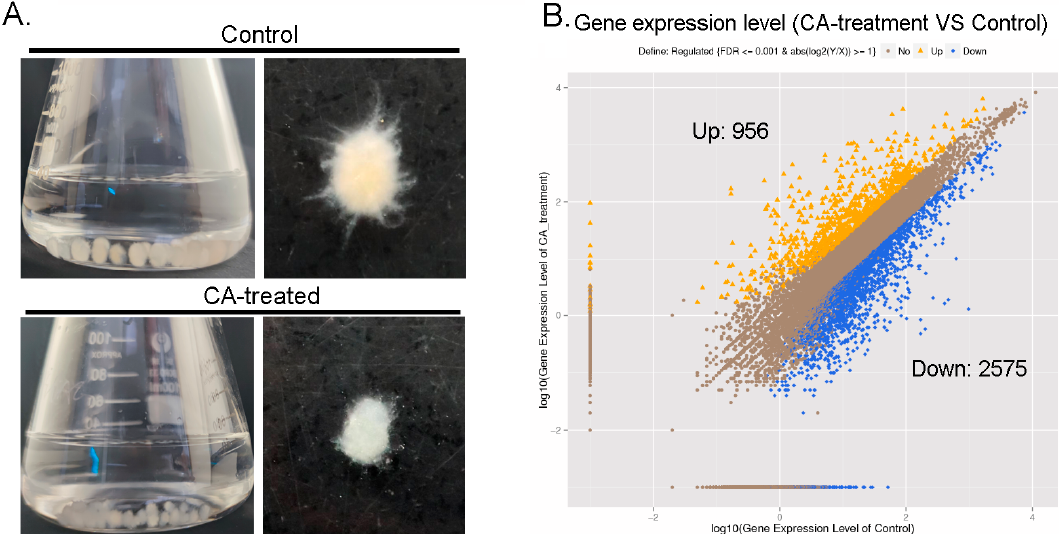
Figure 4. The summary of RNA ‐ Seq of the sample treated with CA. ( A ) The mycelia plug of the P. capsici treated with 1 mM CA, and the mycelia plugs were cultured with V8 medium and transferred to ddH 2 O during photography. ( B ) The distribution of DEGs. Yellow spots represent up ‐ regulated DEGs and blue spots indicate down ‐ regulated DEGs. Those shown in brown are unigenes that did not show obvious changes.